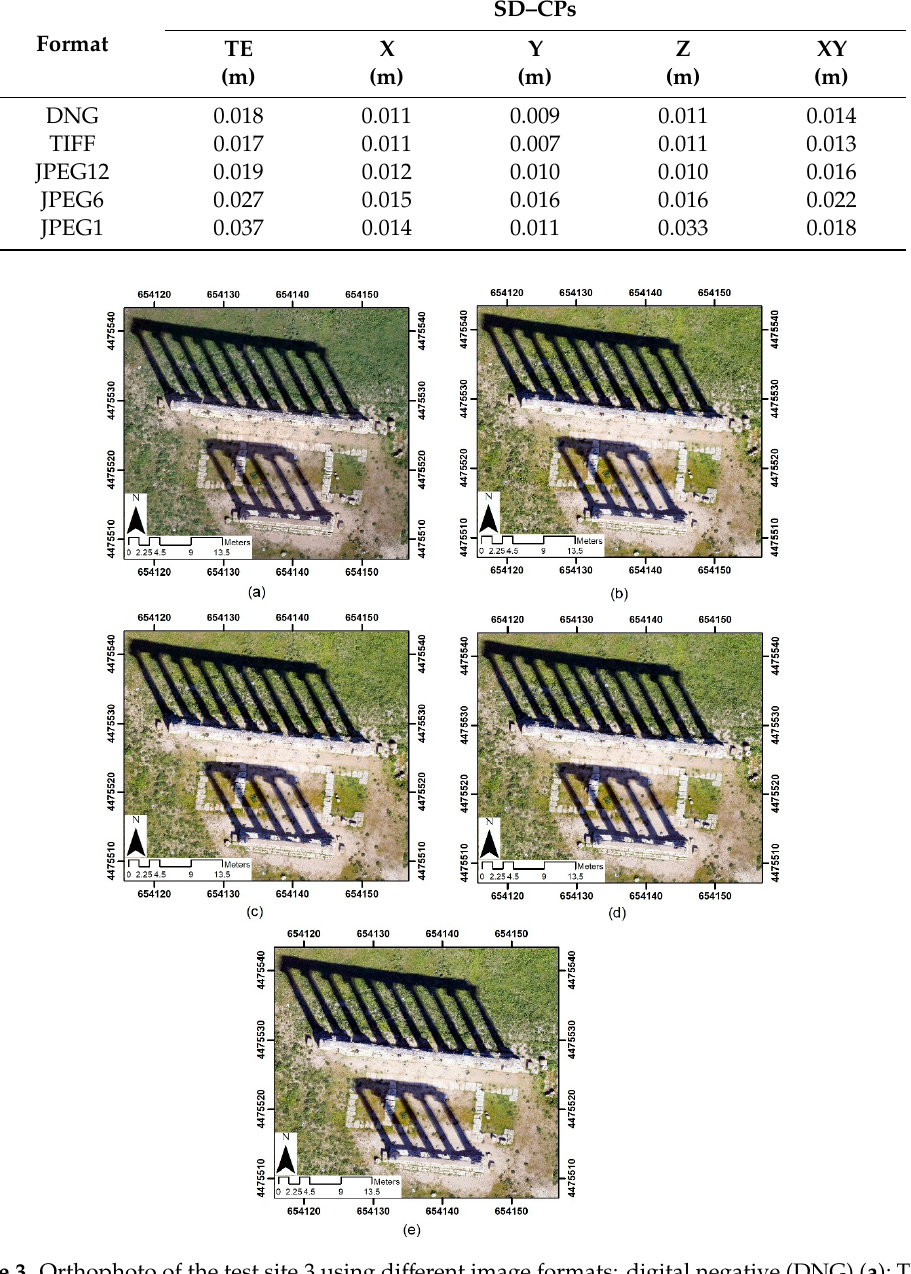
Figure 3. Orthophoto of the test site 3 using different image formats: digital negative (DNG) ( a ); TIFF ( b ); JPEG at low level of compression (JPEG12) ( c ) JPEG at medium level of compression (JPEG6) ( d ) and JPEG at maximum level of compression (JPEG1) ( e ).